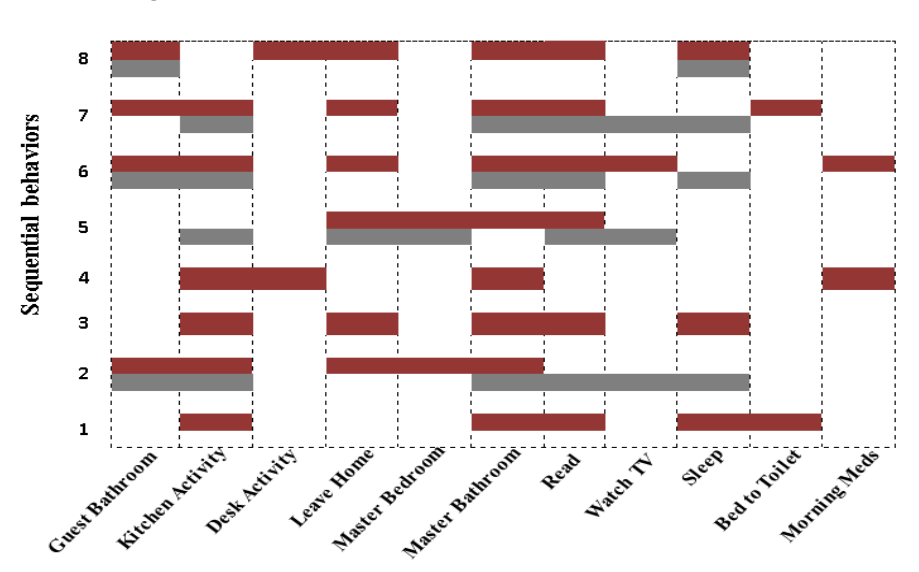
Figure 6. Sequential behavioral patterns for Milan2009.